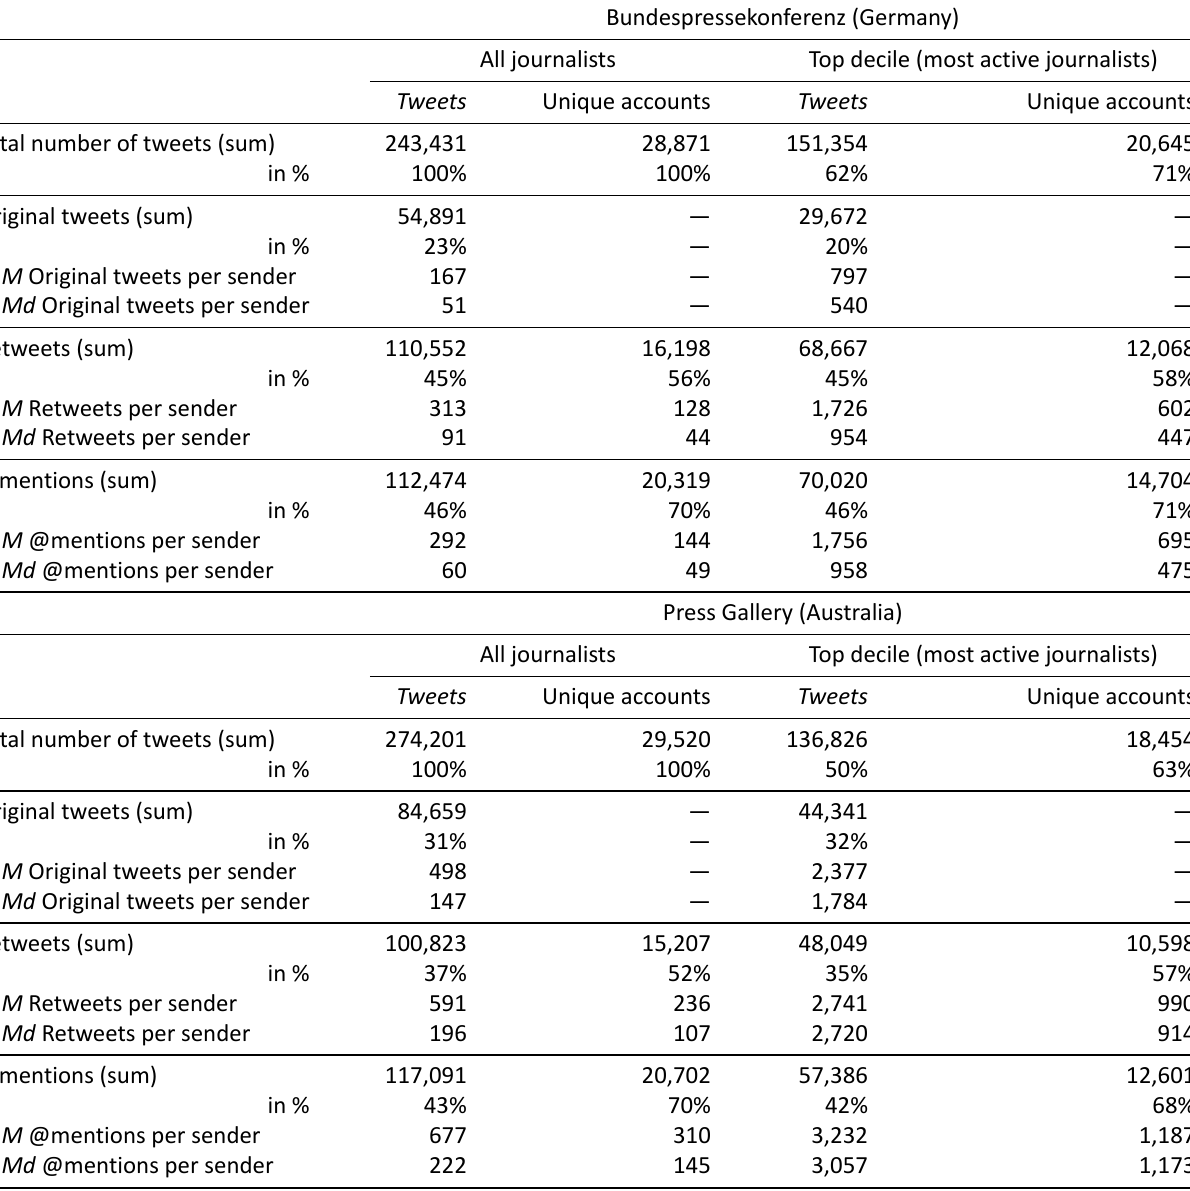
Table 2. Tweeting metrics for press corps journalists